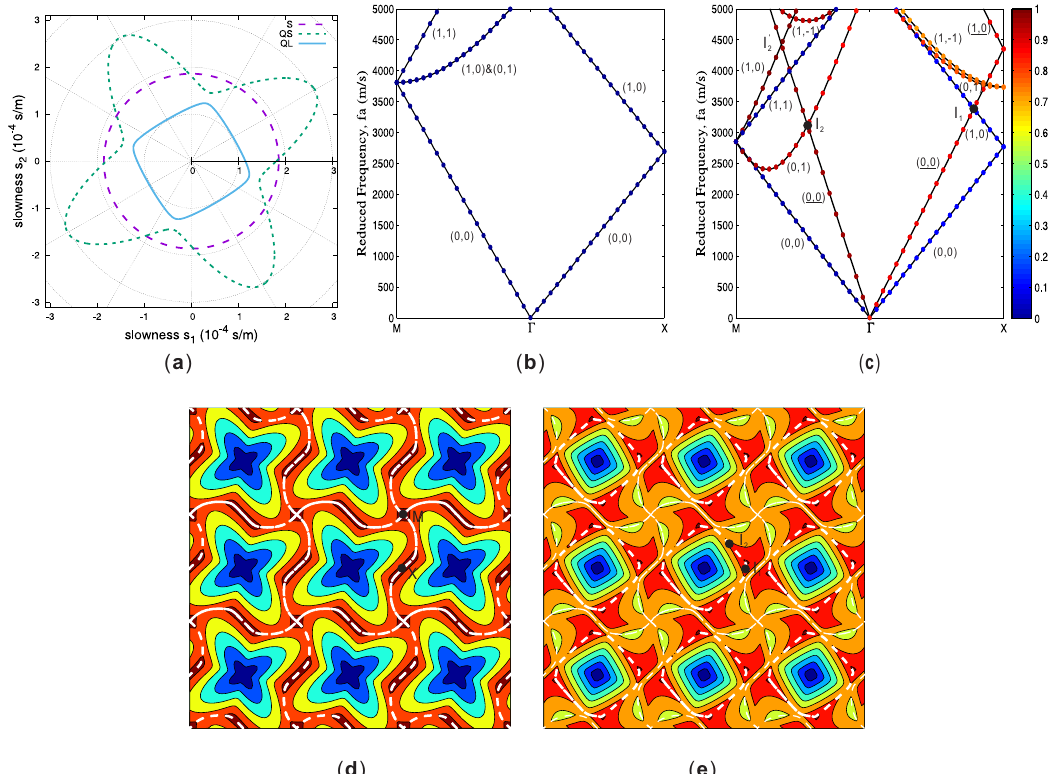
Figure 4. Empty lattice model for in-plane polarized waves in Z-cut rutile with the X − 15 ◦ orientation. ( a ) The three slowness curves are for a pure shear wave (long dashed line), a quasi-shear (QS) wave (short dashed line) and a quasi-longitudinal (QL) wave (solid line). The empty-lattice band structures for ( b ) out-of-plane and ( c ) in-plane polarized waves are shown. Numerical and analytical results are shown with solid circles and lines, respectively. The color scale in ( c ) represents the polarization in the propagation direction, from 0 (shear) to 1 (longitudinal). Each dispersion branch is labeled by an index corresponding to the reciprocal lattice point from which the generating cone originates. Indices for longitudinal branches are underlined for clarity. Points I 1 , I 2 , and I (cid:48) are intersections between QS and 2 QL branches. ( d ) Isofrequency curves are plotted for the first band of in-plane waves. The thick dashed lines represent the intersections between adjacent QS cones. ( e ) Isofrequency curves are plotted for the second band of in-plane waves. The thick dashed lines show the first intersection between QS and QL cones and thin dashed lines show intersections between adjacent QS